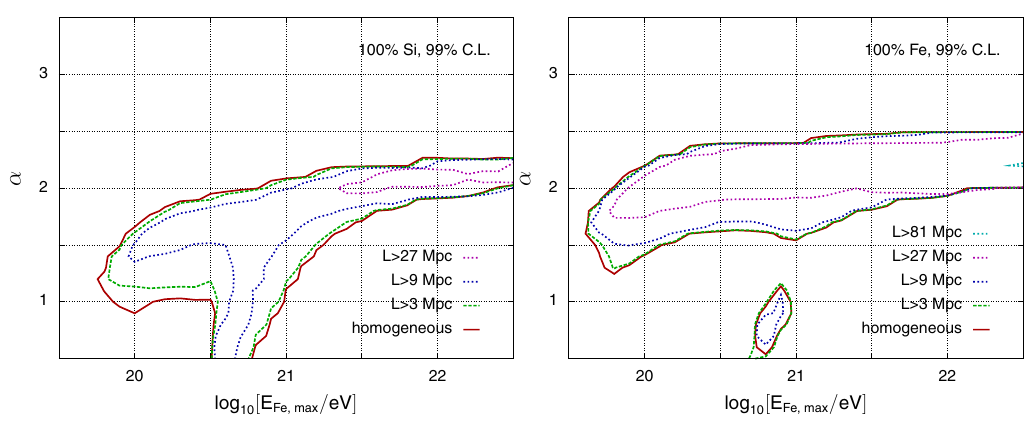
Figure 5. The effect on the 99% C.L. silicon and iron contour plots by the introduction of a minimum source distance.